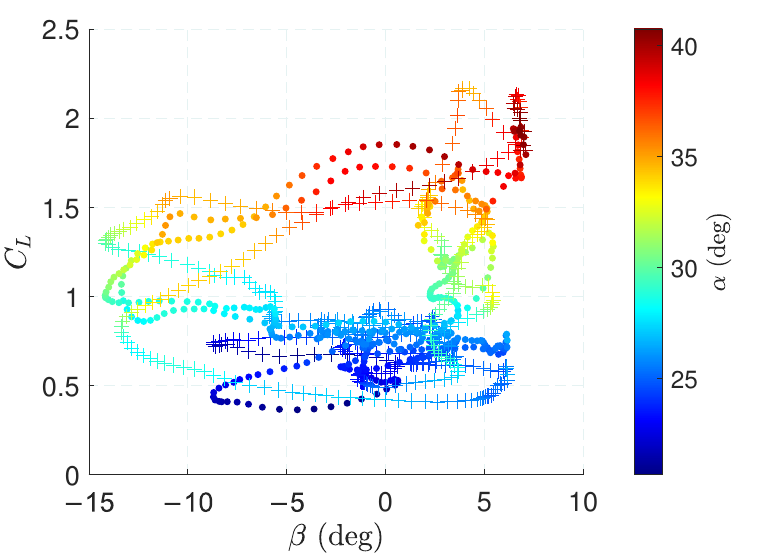
Figure 6. Lift coefficient (crosses and points for experimental and UnPaM data, respectively) versus the sideslip angle with colormap for α